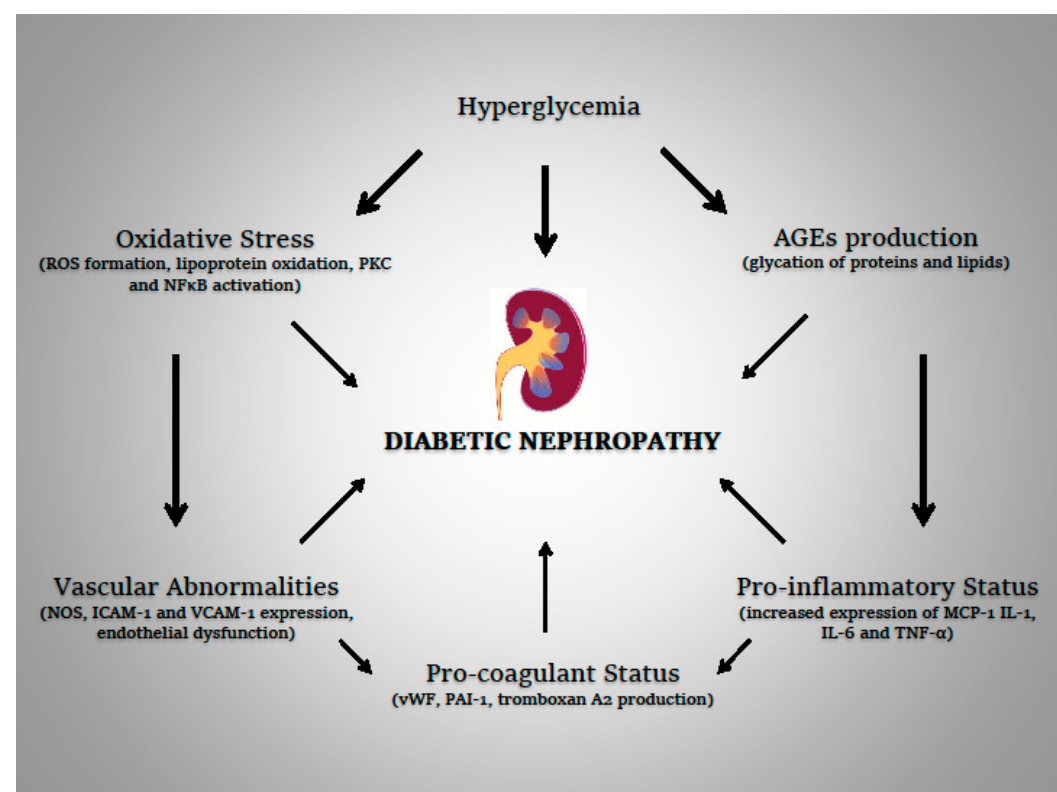
Figure 1. The physiopathological mechanisms involved in the development of diabetic nephropathy are reported. The arrows define the specific physiopatological correlations according to the evidence.